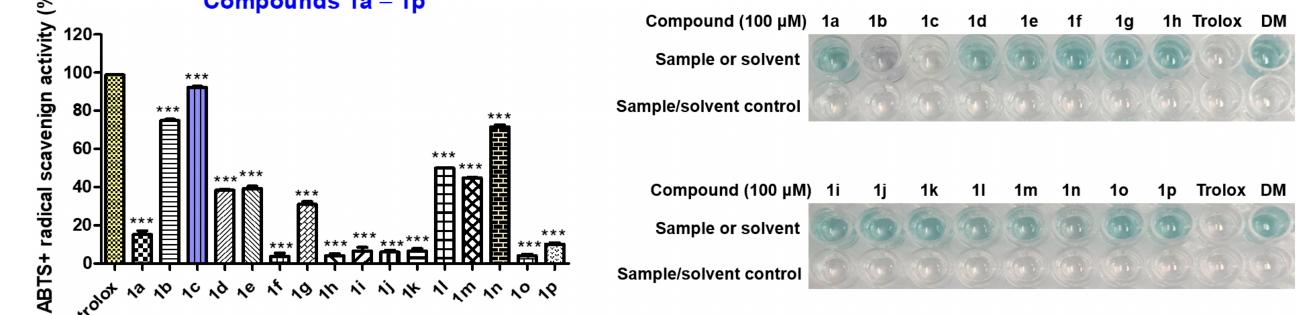
Figure 13. The ABTS radical scavenging effects of compounds 1a – 1p . Trolox was used as a positive control. The ABTS radical scavenging activities of compounds 1a – 1p and trolox were assayed at 100 μ M in DMSO (DM) after 2 min exposure in the dark. The symbol * indicates significant differences between compounds 1a – 1p and trolox. Results are expressed as the means ± standard errors of three different experiments. *** p < 0.001.